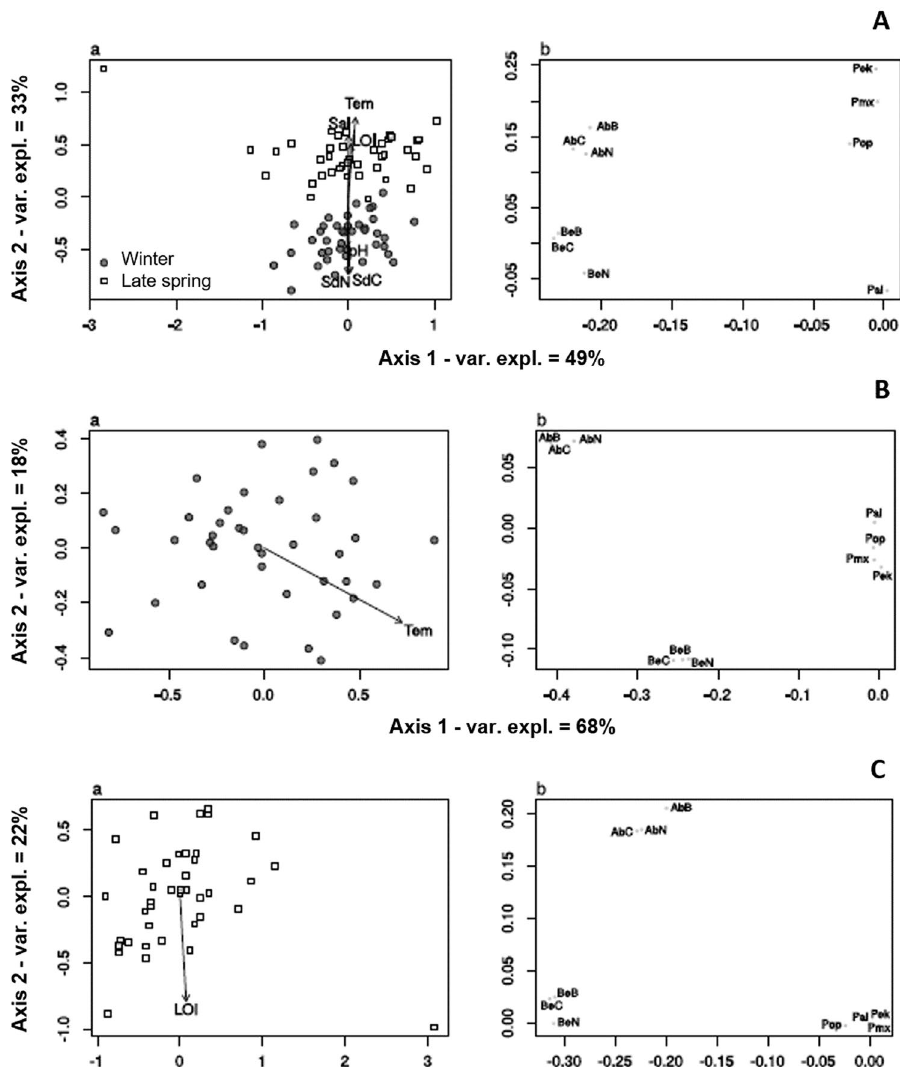
Figure 6. Principal Coordinates Analysis (PCO) showing the variation among sampling sites. Z . noltei traits included are: above- (AbB) and belowground biomass (BeB), above- (AbC) and belowground C pool (BeC), above- (AbN) and belowground N pool (BeN); and photosynthetic parameters (photosynthetic efficiency ( α = Pal), maximum relative electron transport rate (rETR m = Pmx), photoacclimation index (E k = PEk) and optimum irradiance (E opt = Pop). Measured environmental variables are salinity (interstitial water) (Sal), sediment LOI, pH, temperature (Tem), sediment C pool (SdC) and sediment N pool (SdN). The distance matrices contained ( A ) all data, ( B ) data from winter only and ( C ) data from late spring